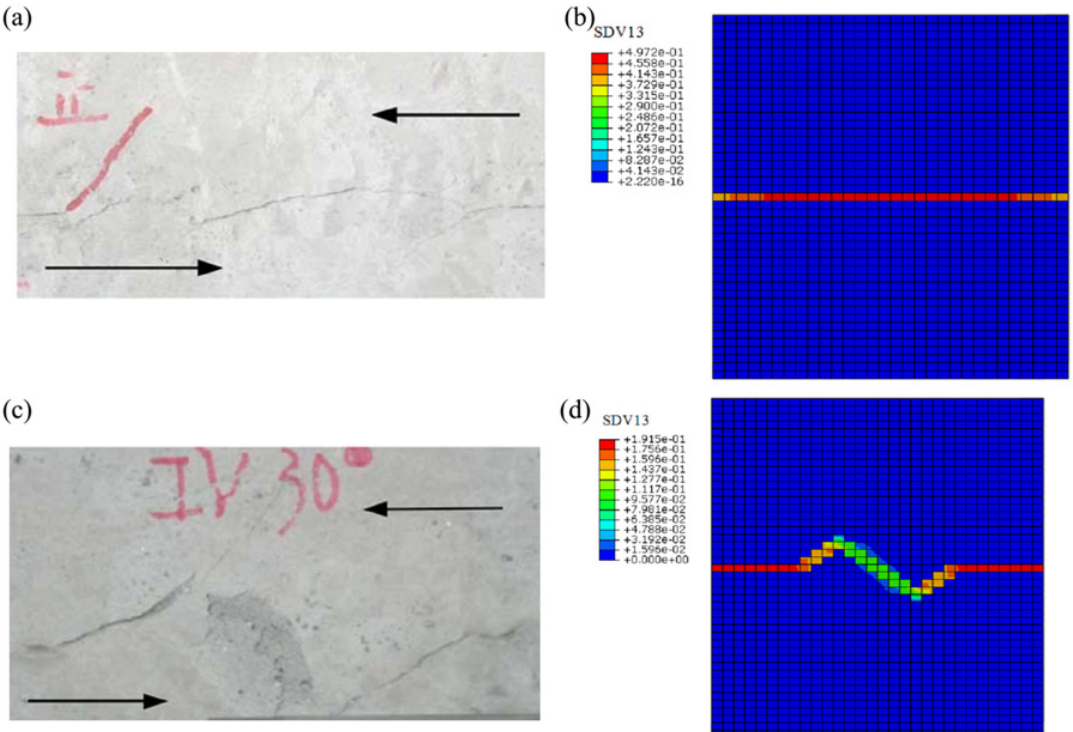
Fig 11. The results of experiment and numerical simulation((a) The failure mode of first rock mass sample in jointed rock direct shear experiment (the visual angles β 0 of joints = 0°);(b) The contour for equivalent plastic deviator strain calculated by proposed constitutive model(the visual angles β 0 of joints = 0°);(c) The failure mode of of second rock mass sample in jointed rock direct shear experiment (the visual angles β 0 of joints = 30°); (d)The contour for equivalent plastic deviator strain calculated by proposed constitutive model(the visual angles β 0 of joints = 30°))